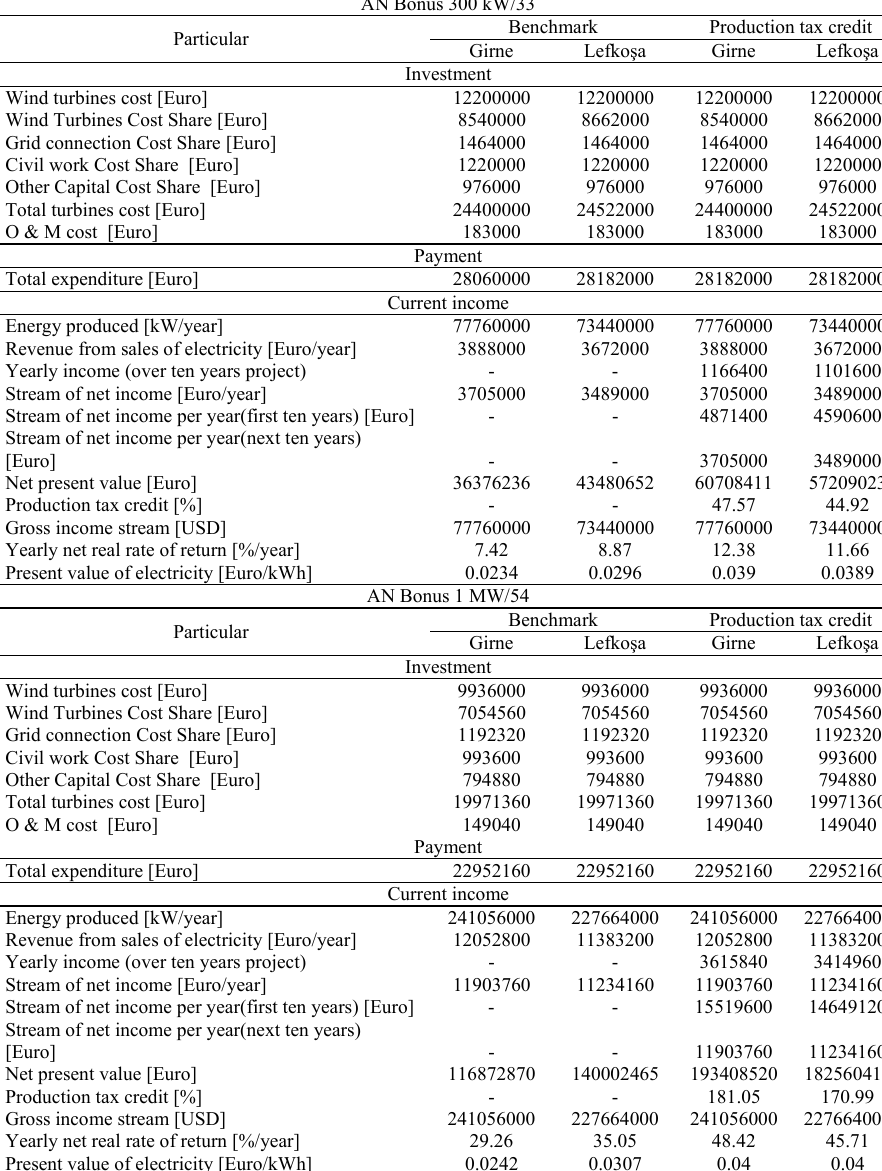
Table 8: Benchmark and production tax credit wind turbine present value cost analysis